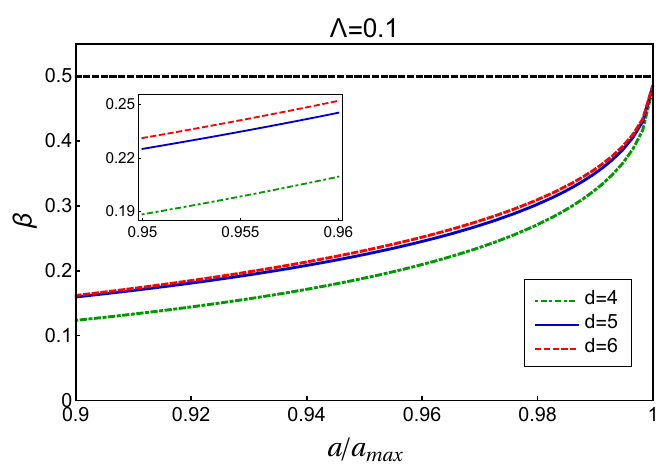
Figure 5 . A comparative study of the behaviour of the parameter (cid:12) with spacetime dimensions has been presented. For this purpose we have drawn (cid:12) as a function of ( a=a max ) at a (cid:12)xed value of the cosmological constant ((cid:3) = 0 : 1) in four (green dot-dashed line), (cid:12)ve (blue solid line) and six (red dashed line) dimensional spacetimes for Kerr-de Sitter black holes. As the plots clearly depict, none of them really crosses the black dashed line corresponds to (cid:12) = 1 = 2. Thus cosmic censorship conjecture is being uphold for Kerr-de Sitter black holes even in presence of higher